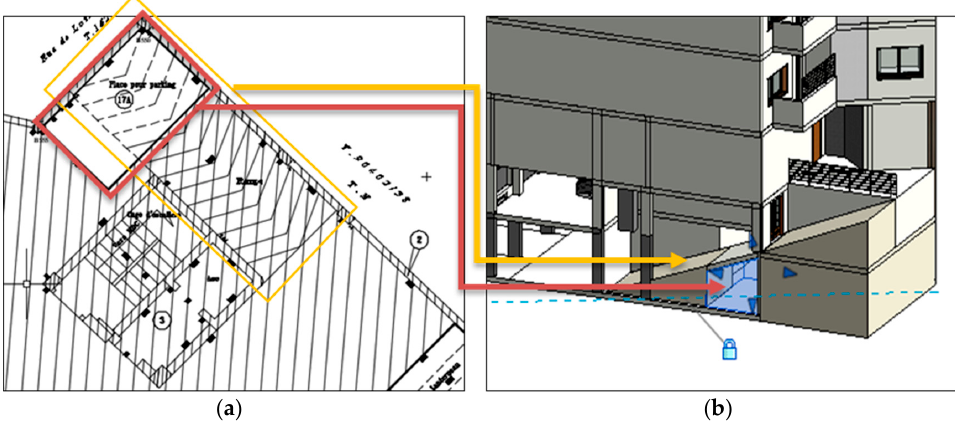
ISPRS Int. J. Geo-Inf. 2021 , 10 , x FOR PEER REVIEW Figure 8. ( a ) A 2D representation of the ramp and the parking space; ( b ) the associated 3D model. 2. The shops are located on the ground floor and extend in height up to the first-floor level. This situation creates voids at the upper ground level, which are projected on 2D plans and designated by “Vide/Commerce” (Figure 9).